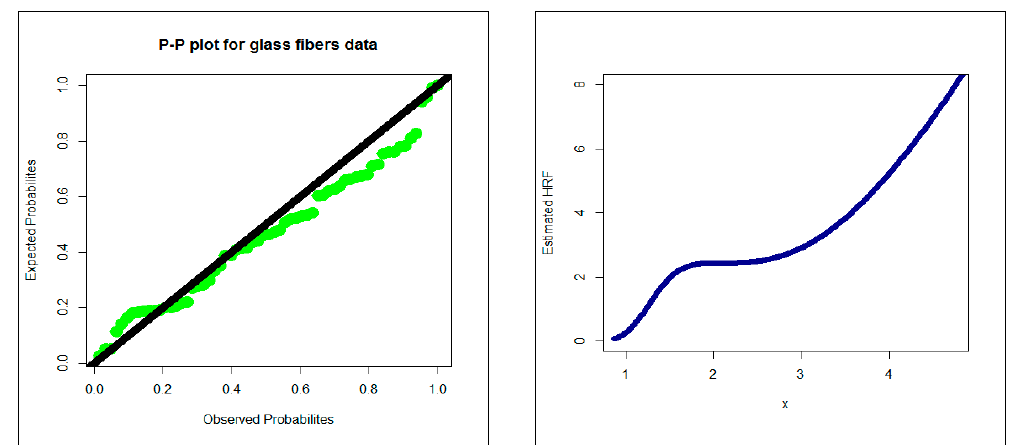
Figure 6. P-P panel (left) and estimated HRF (right) for the glass fibers data.